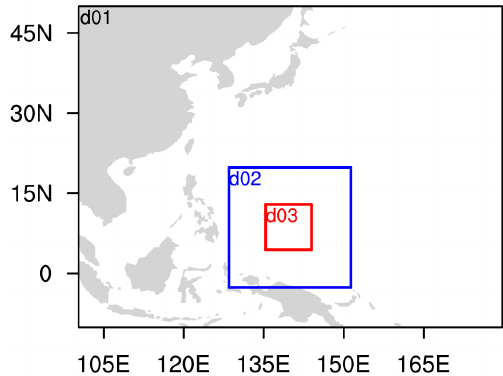
Figure 1. WRF nested domain configuration for Typhoon Yutu (2007) simulation. The first domain (d01, black) has 462 × 396 grids, the second domain (d02, blue) has 399 × 399 grids, and the third domain (d03, red) has 450 × 450 grids.